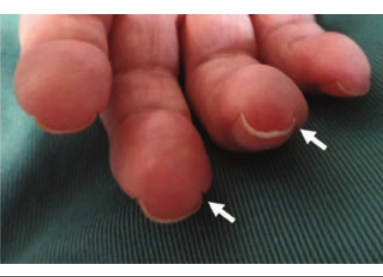
Figure 1. Convex transverse overcurvature of the nails that pinched the fingertips (arrows) 13 months after onset of amy- otrophic lateral sclerosis in a patient who experienced rapid deterioration and advancement of the